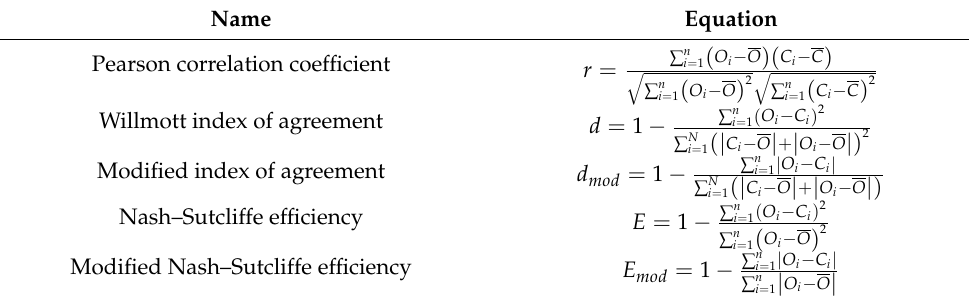
Table 2. Efficiency